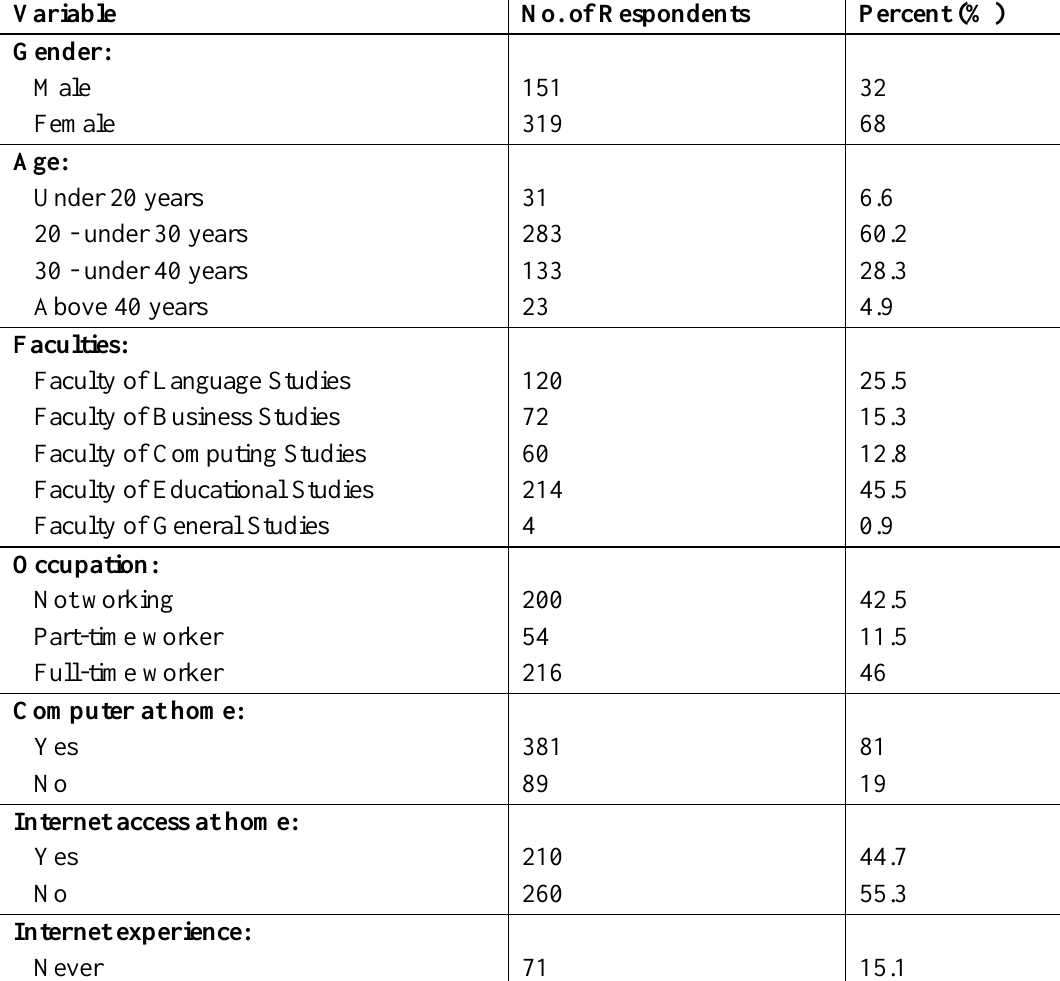
Summary of Demographic Characteristics of Research Participants Variable No. of Respondents Percent